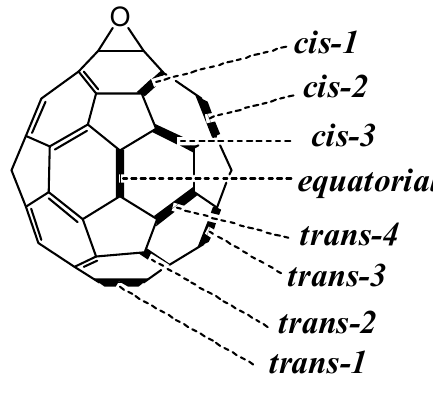
Figure 1. Positional notation of the fullerene epoxide, C